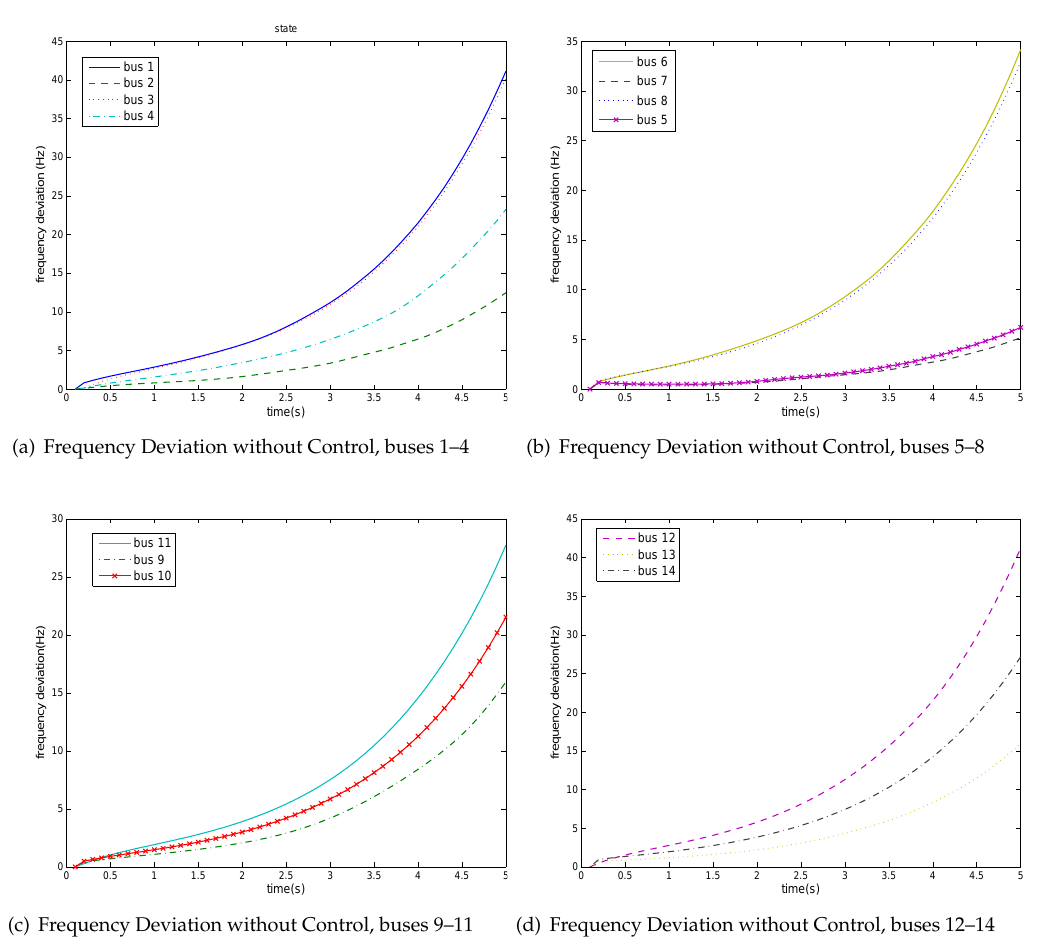
Figure 3. Frequency deviation of IEEE 14 bus system without